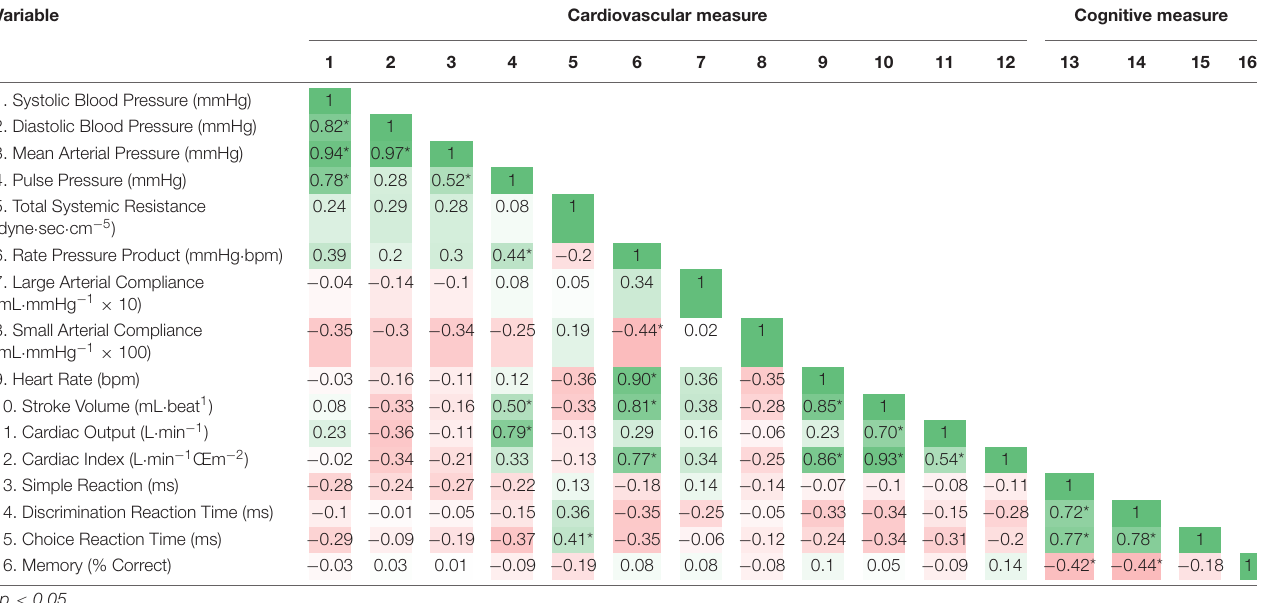
TABLE 5 | Correlation matrix: post-race associations between indices of cardiovascular function and cognitive performance and displayed as Pearson correlation coefficient. Variable Cardiovascular